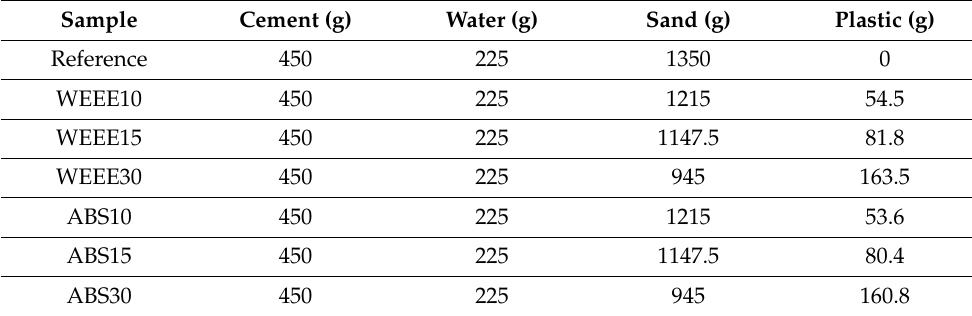
Table 2. Composition of the different